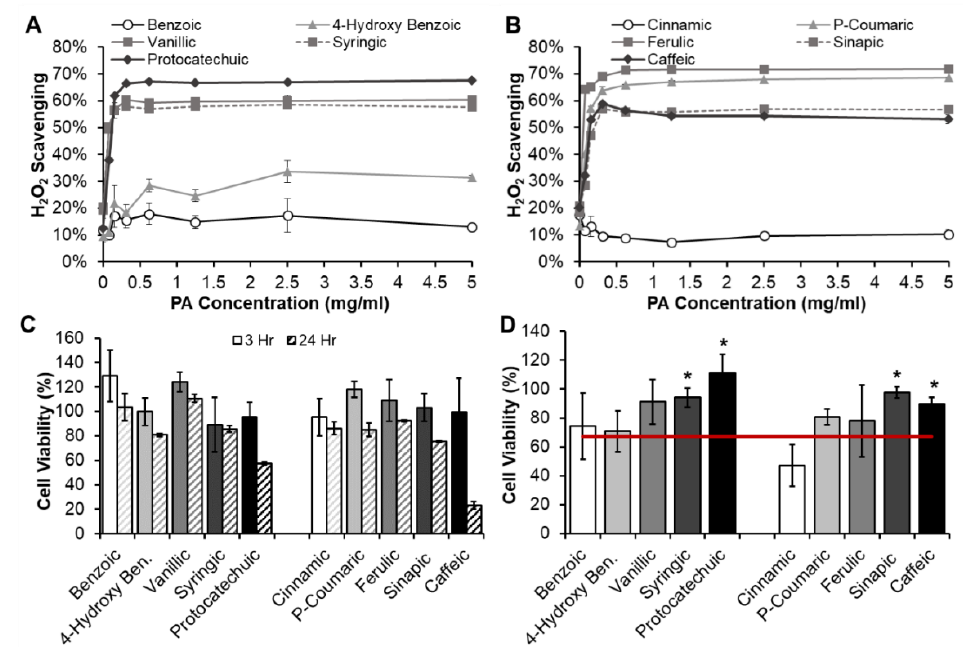
Figure 3. Antioxidant properties of PAs as quantified by hydrogen peroxide (H 2 O 2 ) scavenging capabilities from the ( A ) benzoic acid group and ( B ) cinnamic acid group. PA ( C ) 3T3 cytocompatibility and ( D ) protective effects against H 2 O 2 for 3T3s. Red line: DMSO + H 2 O 2 control. *Significant increase ( p < 0.05) in viability relative to DMSO + H 2 O 2 control. n = 3, mean ± standard deviation displayed.